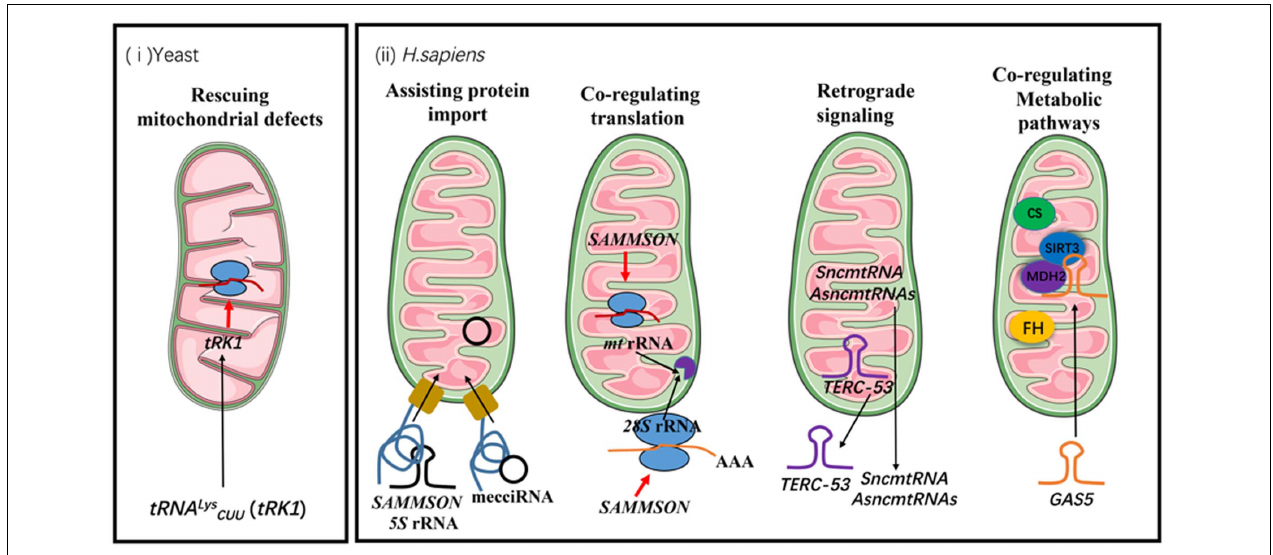
FIGURE 1 | The functions of mitochondrial non-coding RNAs in communication between mitochondria and other cellular compartments. The black arrows indicate the directions of trafficking. The red arrows indicate positive regulations of cellular processes. FH stands for fumarate hydratase and CS stands for citrate synthase.